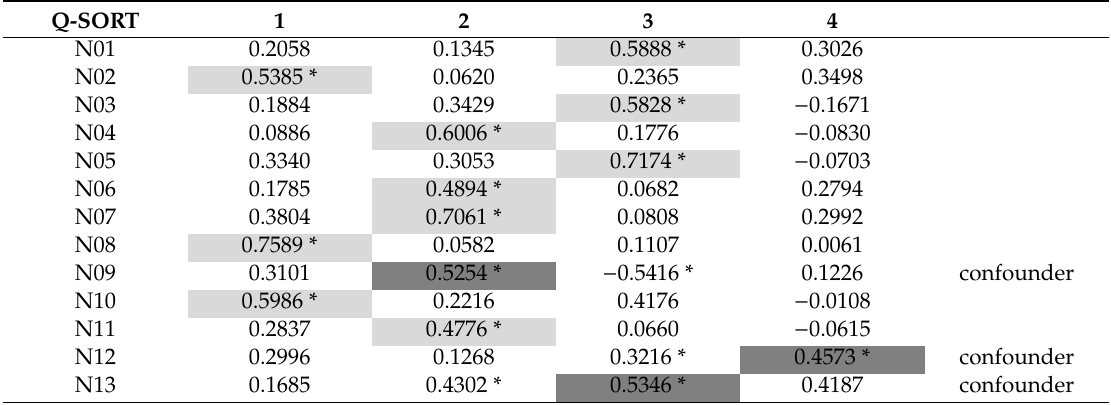
Table A2. Factor loadings for four-factor